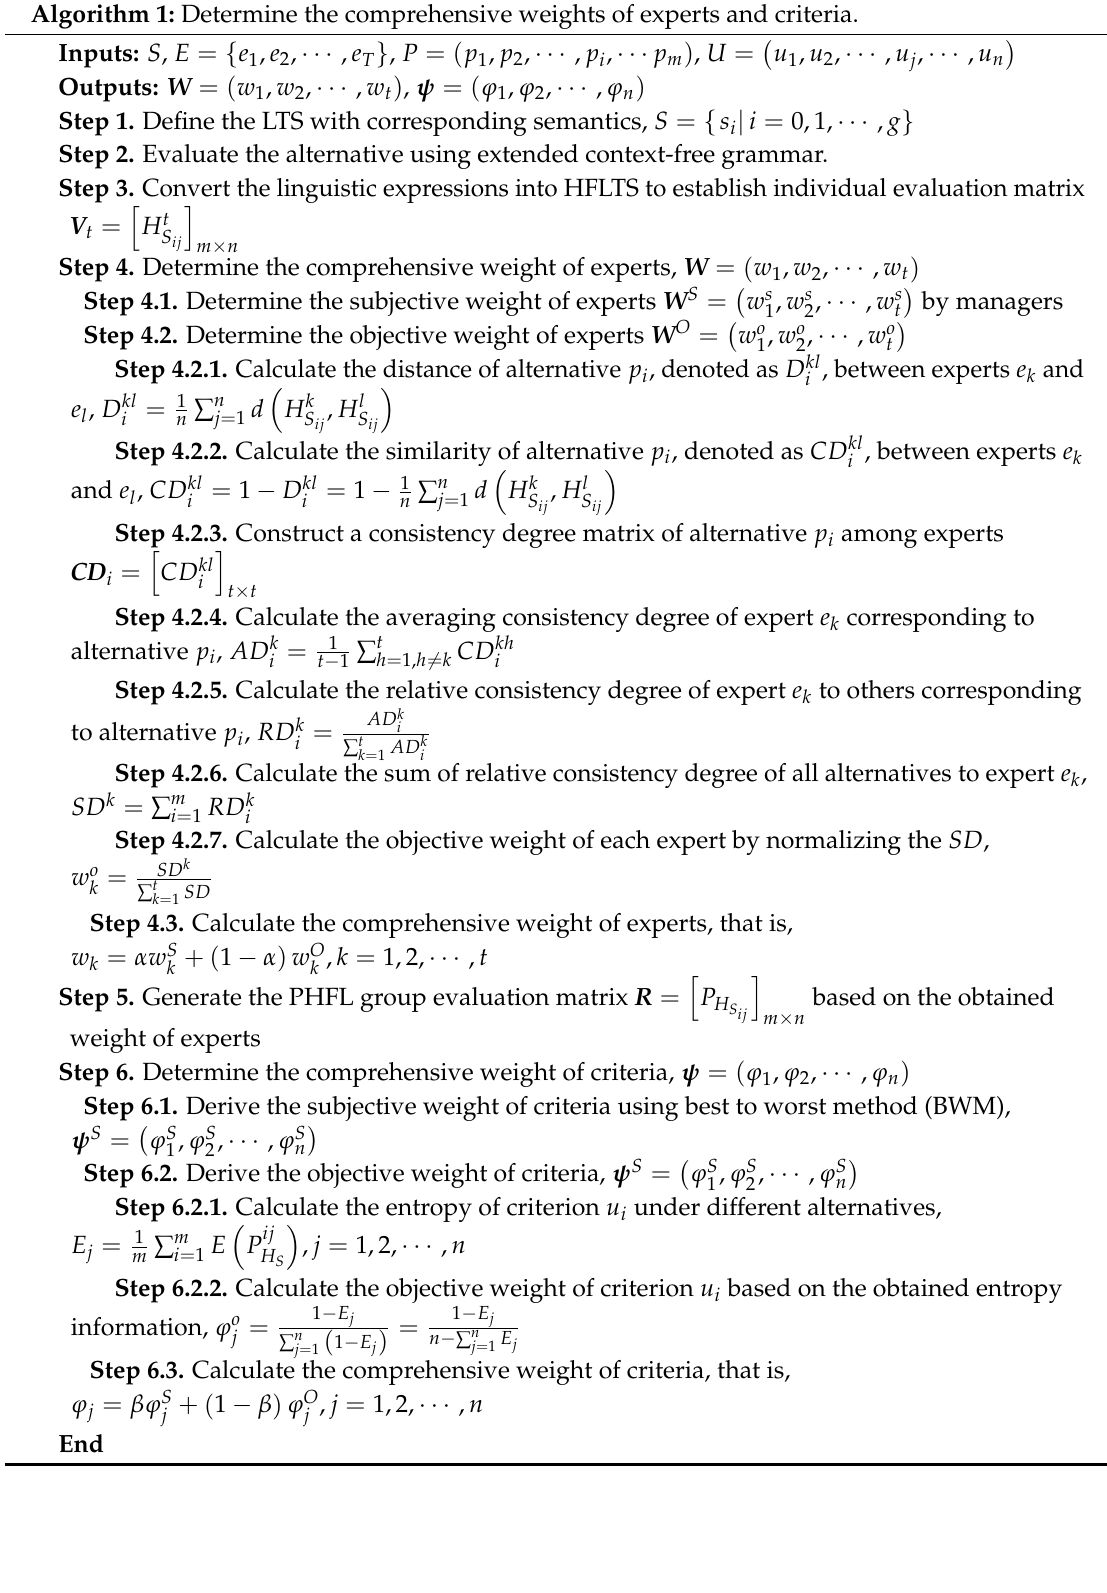
Algorithm 1: Determine the comprehensive weights of experts and